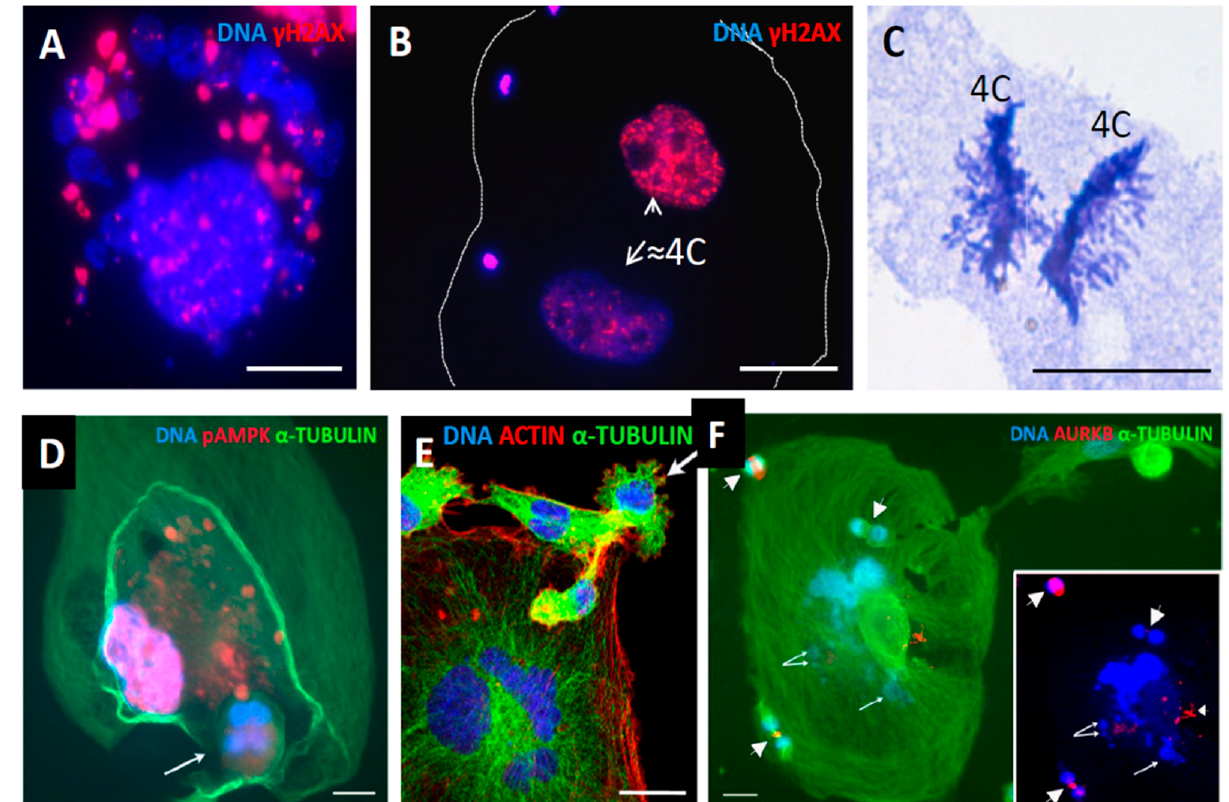
Figure 10. The production of fragmented cytosolic DNA in repeated cycles of MS in polyploid giant cells; its separation from the repairing sub-nucleus by autophagy and support from a polyploid giant for the budding and homing of mitotic survivors. ( A ) MS positive for DNA DSBs (second week post DOX). ( B ) A giant cell with two ~4C sub-nuclei, one is γ H2AX positive, while the other is free of DNA DSBs, and three small clusters of the sorted DSB-enriched DNA at the cytoplasm periphery. ( C ) Bi-polar anaphase of the equal 4C binemic chromosome groups from an 8C MDA-MB-231 cell–a clear indication of reduction division—on day 19 post-DOX-treatment. ( D ) The possible excystation of a tetra-nuclear subcell (arrow) leaving a giant cell, while another subnucleus (~8C) is positive for pAMPK, indicating its autophagic degradation (republished from [4]). ( E ) A giant multinuclear cell is budding a sub-cell (arrow) from a fragment of a polyploid giant cell 7 weeks post-DOX treatment, expelling a daughter cell, with the actin twisting around the anaphase spindle. ( F ) A super-giant amoeboid cell with a deteriorating nucleus (arrowed, better seen on the DAPI-stained image in insert) homing three small cells performing mitosis (arrowheads): metaphase, anaphase, and telophase. Bars = 25 µ m. ( E , F ) republished from [4] with an open access CC BY 4.0 license; ( C , D ) from [11], the article can be found https://www.researchgate.net/publication/322581015. Accordingly, it appears that polyploid giant cells sort the DNA damage between subnuclei and deliver small viable survivors, but themselves only produce even more cytosolic DNA, degraded by autophagy for recycling, and also energy to feed the offspring and to stimulate their mitoses, also by a secreted microenvironment, until they are self- sufficient and capable of forming clones. Additional data are presented in Figure 11. It is seen that the polyploid giant cells (large nuclei) remain after DOX treatment predominantly with DNA DSBs, while the small cells (presumably delivered from them) become repaired. WB analysis of the DNA autophagy mediator p62 (Figure 11B), shows its upregulation in terms of DNA-damage response, in line with literature